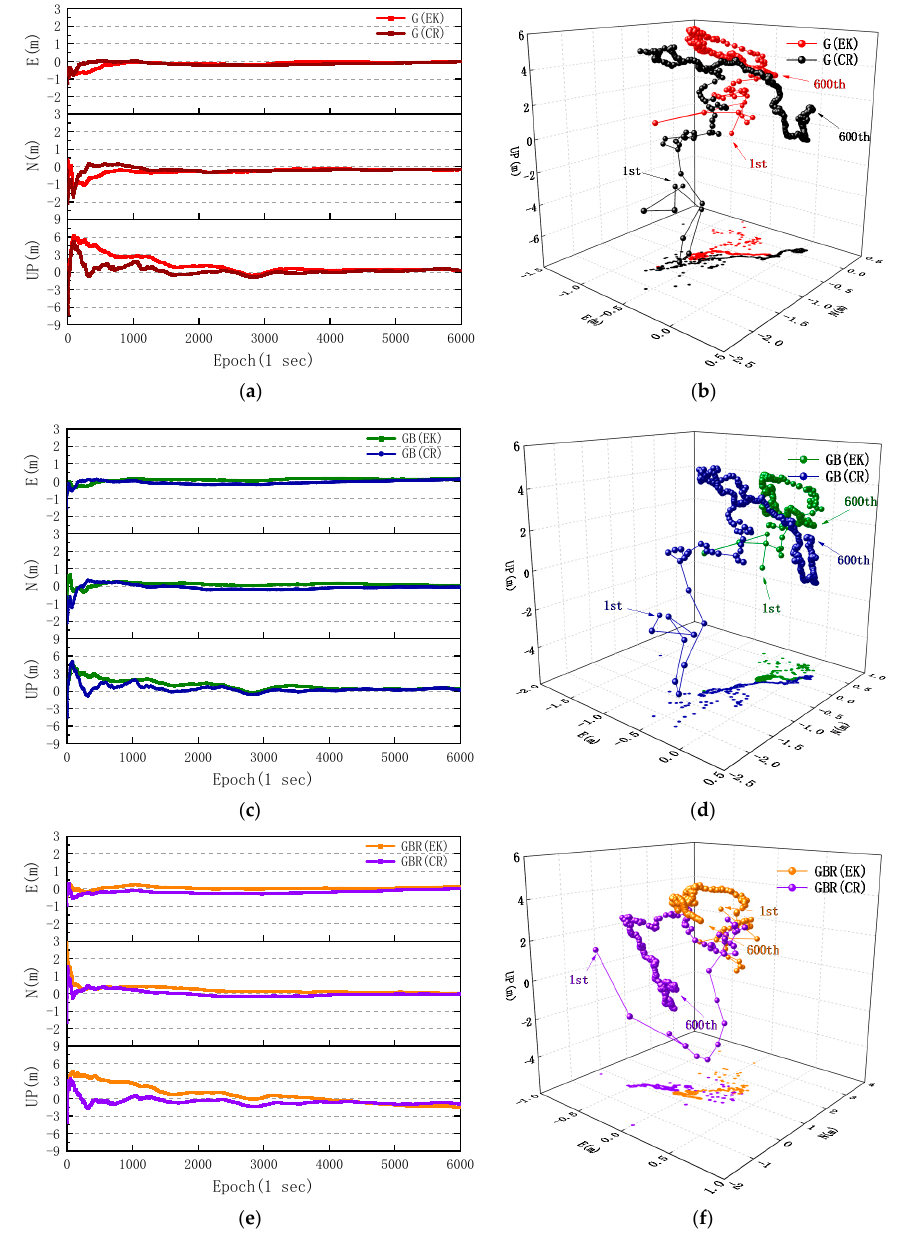
Figure 6. Comparison of the static PPP errors with different combinations of GPS, GPS/BDS, and GPS/BDS/GLONASS observed by the Huawei Mate30 in three directions. ( a ) GPS; ( b ) three-dimensional deviation points of GPS. ( c ) GPS/BDS; ( d ) three-dimensional deviation points of GPS/BDS. ( e ) GPS/BDS/GLONASS; ( f ) three-dimensional deviation points of GPS/BDS/GLONASS. The E and N denote east and north direction. The EK denotes the conventional PPP method with an elevation-dependent stochastic model and Kalman filter estimation model, and the CR denotes the proposed PPP method with a C / N 0 -dependent stochastic model and robust Kalman filter estimation